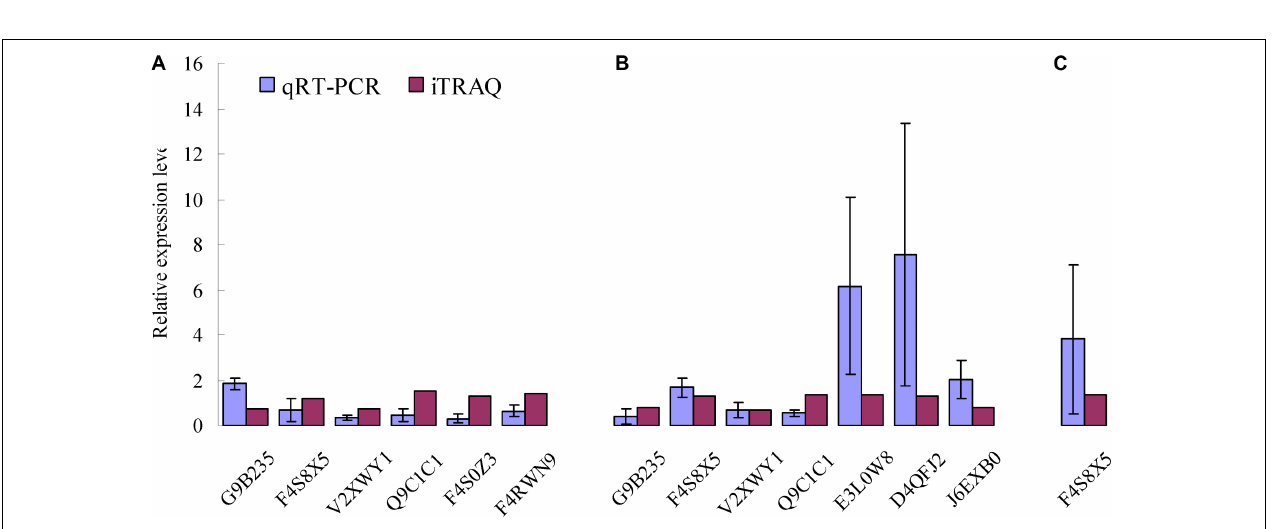
FIGURE 4 | Comparison of encoding gene expression levels and protein levels of the selected enriched proteins identified by iTRAQ analysis in the combinations CYR32-5 vs. CYR32 (A) , CYR32-61 vs. CYR32 (B) , and CYR32-61 vs. CYR32-5 (C) .